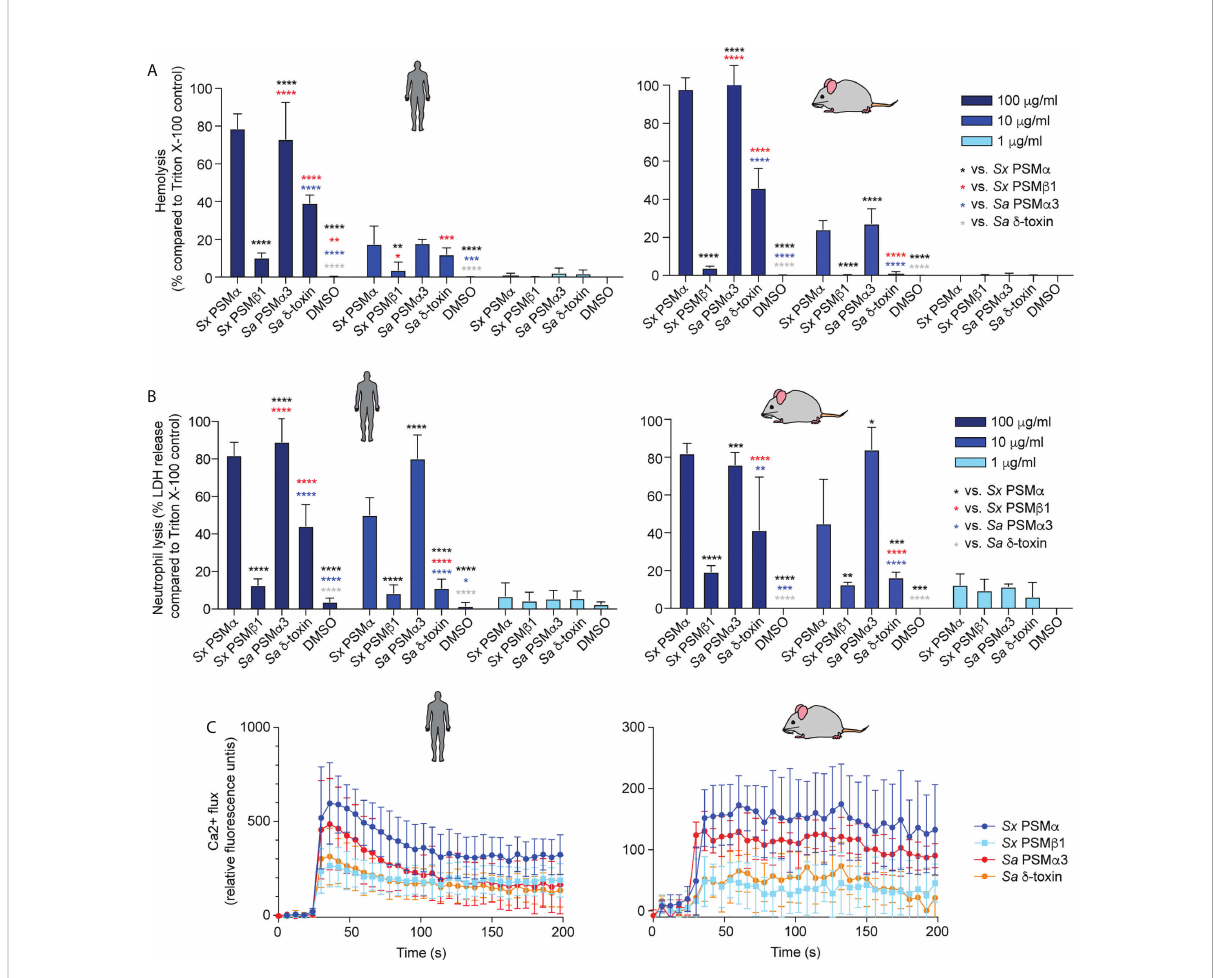
FIGURE 3 Cytolytic and pro-in fl ammatory capacities of main S. xylosus PSMs. Capacity of synthetic PSM peptides representative of predominant S. xylosus PSM species to lyse (A) human and mouse erythrocytes, (B) Human and mouse neutrophils and (C) induce calcium fl ux in human and mouse neutrophils. Synthetic S. aureus PSM a 3 and d -toxin were measured for comparison. For hemolysis and lactate dehydrogenase (LDH) release assays, triplicate measurements were performed with whole heparinized blood and puri fi ed neutrophils obtained from three donors, respectively. For calcium fl ux assays, duplicate measurements were performed from two donors and PSMs were added at a fi nal concentration of 100 nM. Statistical analysis is by 2-way ANOVA with Tukey ’ s post-tests. *, p<0.05; **, p < 0.01; ***, p < 0.001; ****, p < 0.0001; Error bars show the mean ± SD. Mouse and human schemes are from